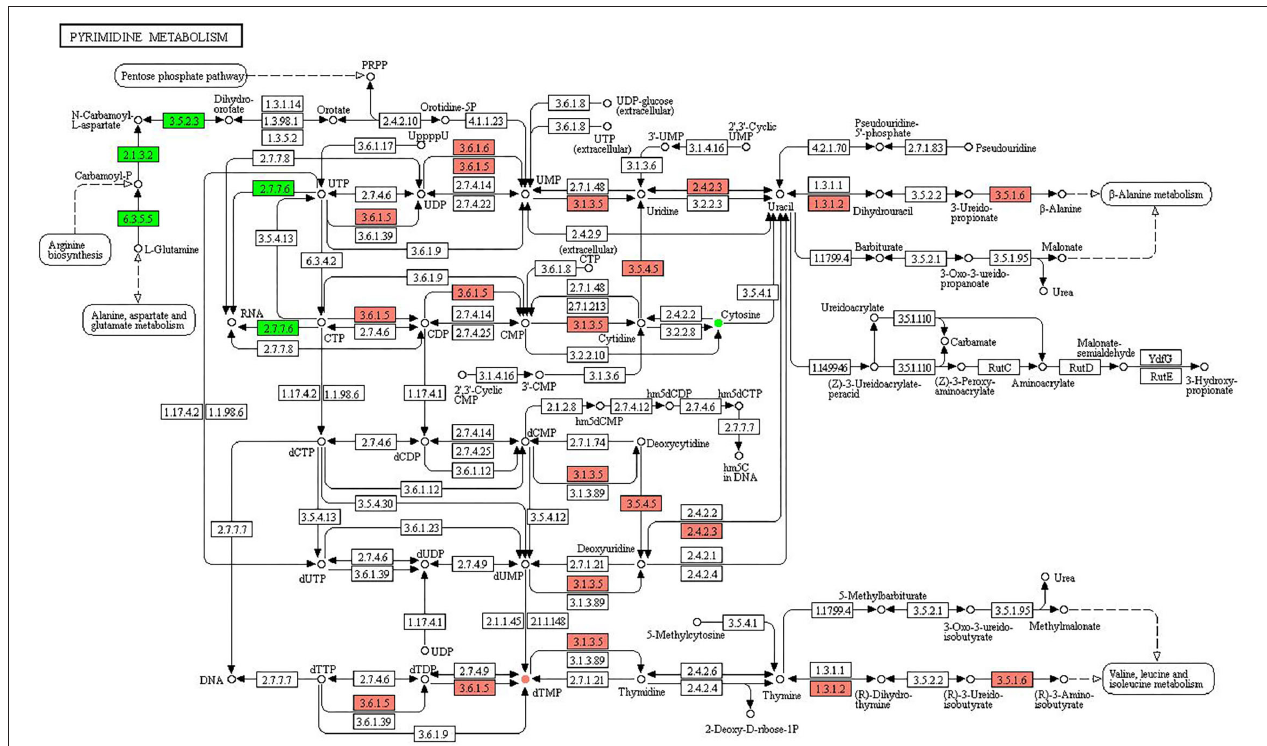
FIGURE 8 | KEGG pathway of pyrimidine metabolism. The boxes represent gene products, and the circles represent metabolites. The gene products in red and green are the upregulated and downregulated genes, respectively. The metabolites in red and green are the upregulated and downregulated metabolites, respectively.